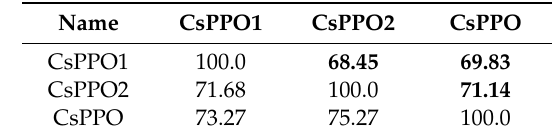
Table 1. Percentage of similarity among three tea-plant PPO sequences, calculated for both nucleotide and amino-acid sequences using MEGALIGN (DNAStar). Protein identities are in bold.